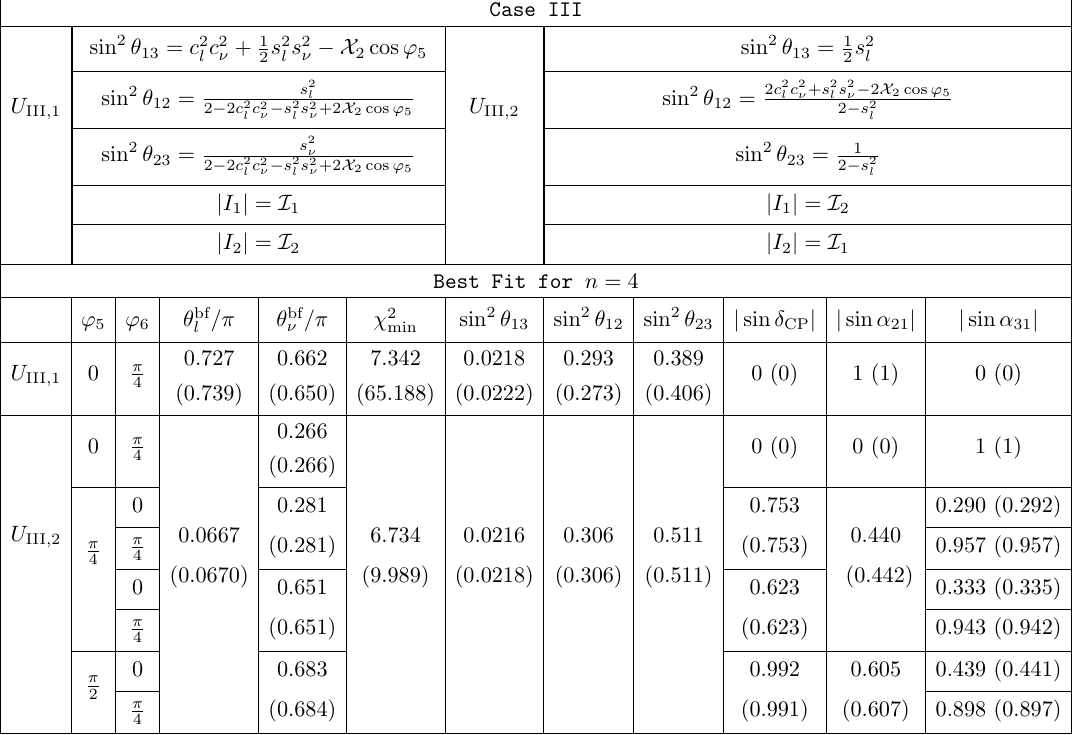
Table 8 . The results for the mixing parameters in case III, and the absolute value of the Jarlskog invariant J CP is given by j J CP j